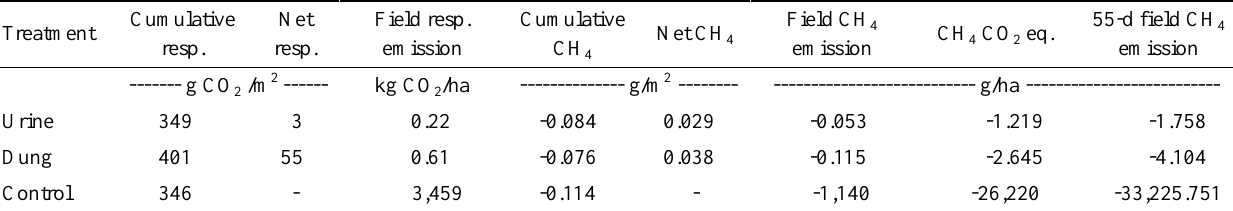
study period Treatment